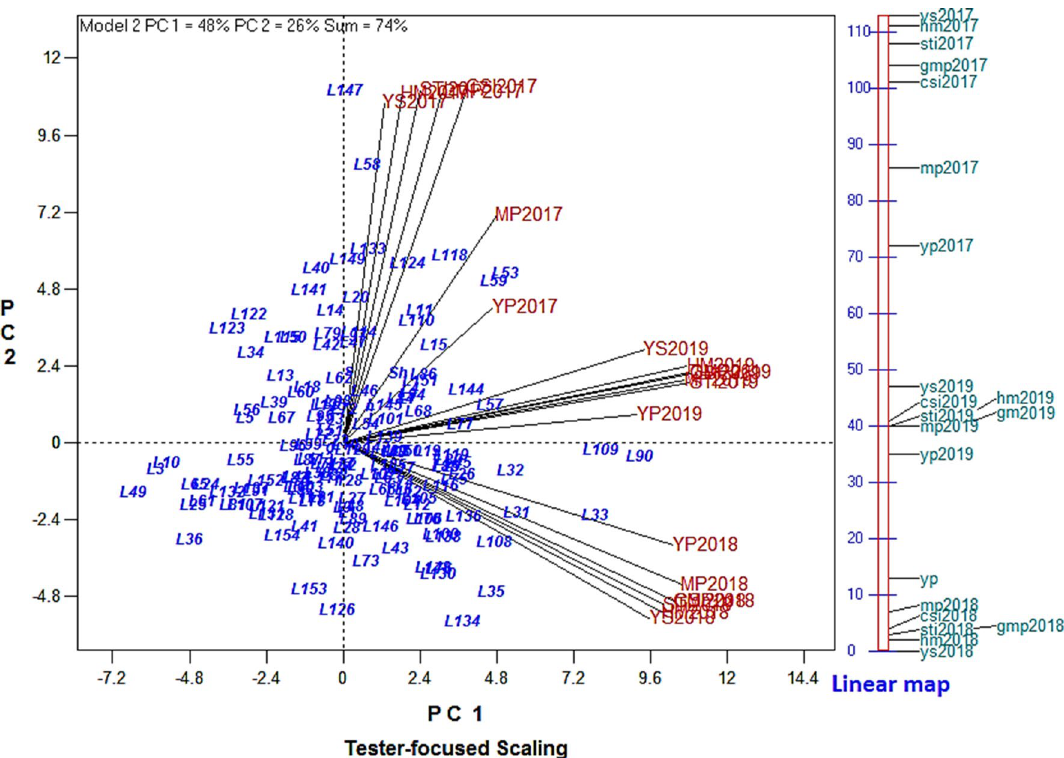
Figure 8. GT-biplot for different drought tolerance indices based on the grain yield data of 152 rice RILs, parental (IR28 and SH: Shahpasand) and check varieties (N; Neda, S; Sadri, D; Dorfak) under non-stress and drought stress conditions in 3 years (2017–2019). The angles less than 90° between the new developed index of CSI and other indices; grain yield under non-stress (YP), and drought stress condition (YS) represent that CSI had strong positive relationship with them. Linear map displays the angles among the vectors of the indices and grain